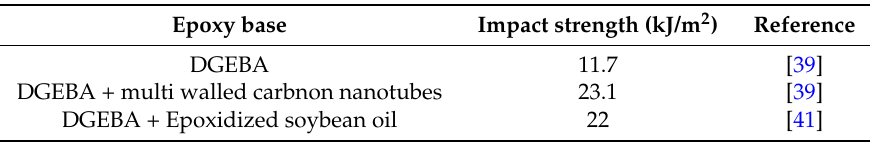
Table 4. Unnotched Charpy impact strength of epoxy based